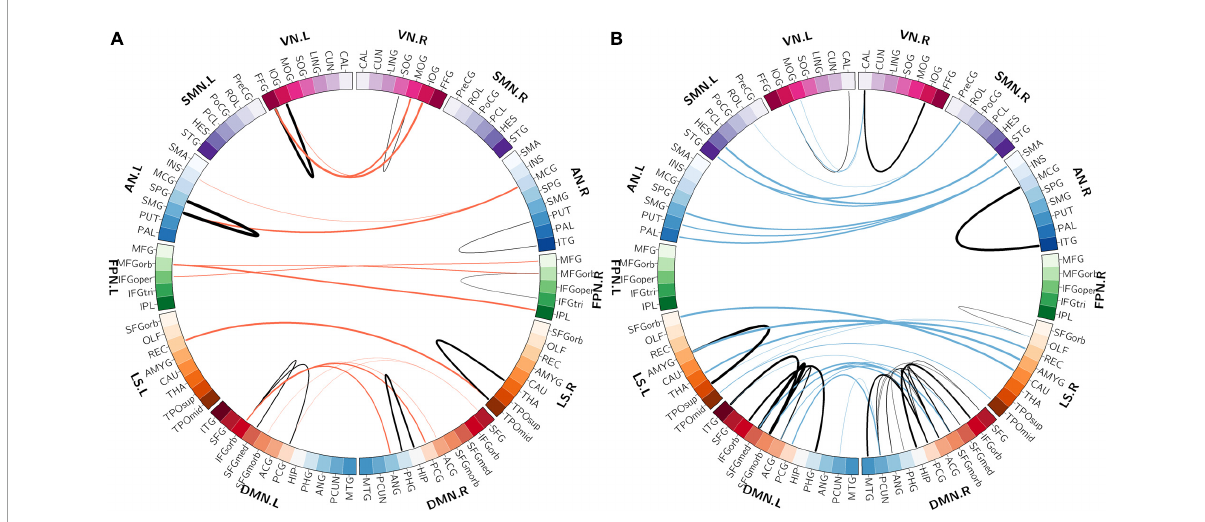
FIGURE5 The distributions of intra-network FCs. (A) The spatial distribution of the selected intra-network FCs with higher classification weights in patients with OSA compared with controls. (B) The spatial distribution of the selected intra-network FCs with lower classification weights in patients with OSA compared with controls. The thickness of lines represents the absolute weight values and the black lines indicate functional connectivity within one functional network. VN, visual network; SMN, somatomotor network; AN, attention network; FPN, frontoparietal network; DMN, default mode network; LS, limbic system.